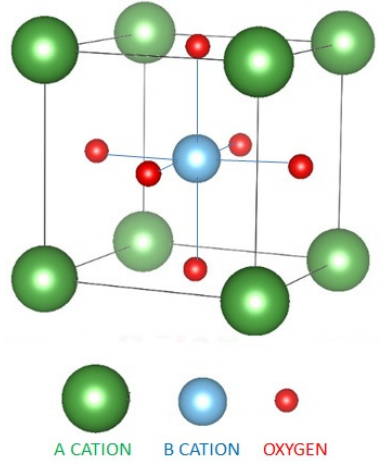
Figure 1. Inorganic ABO 3 perovksite structure.